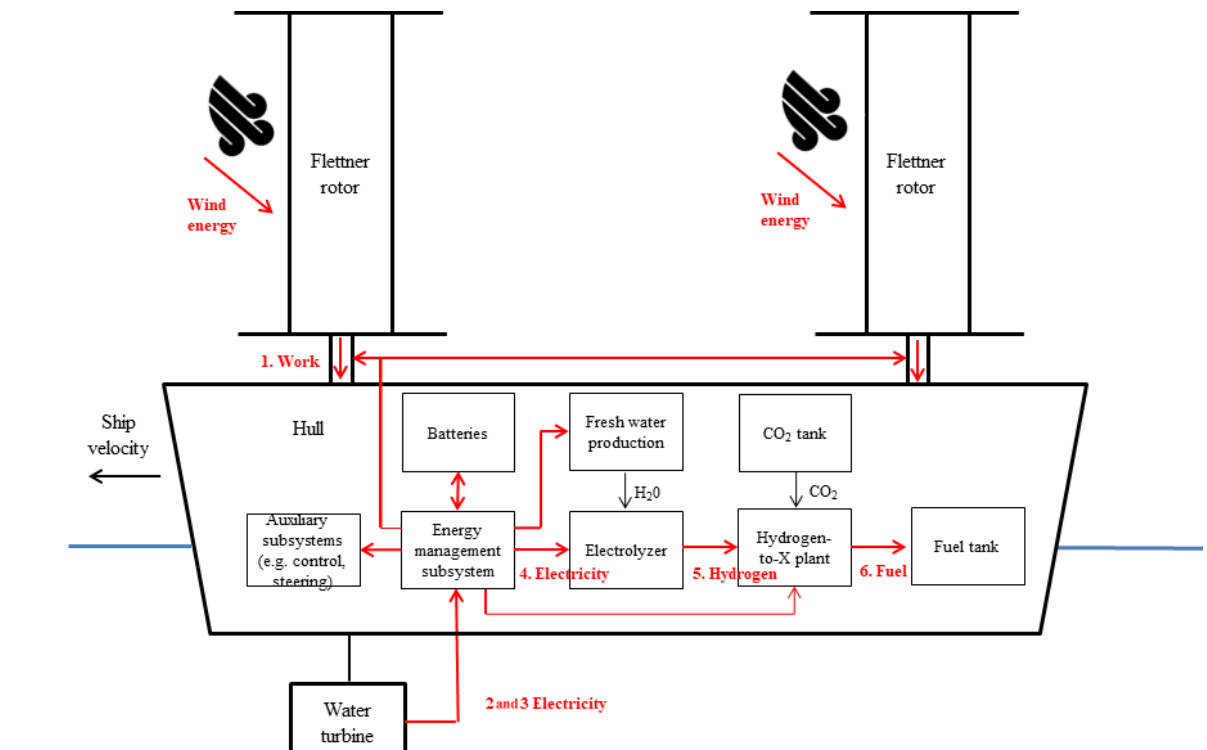
Figure 3. Description of the energy flows in a methanol-producing energy ship. Note that in this schematic, the wind propulsion subsystem is Flettner rotors. However, other sail concepts can be